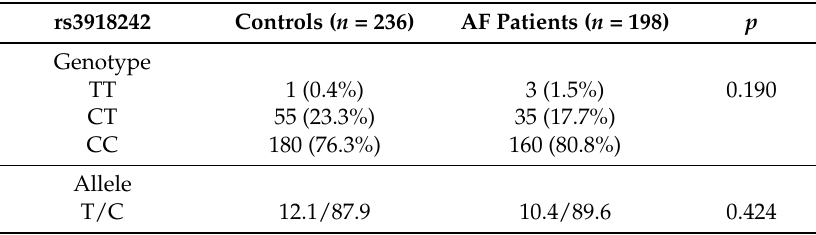
Table 2. Distribution of genotype and allele for MMP9 rs3918242 polymorphism in 200 patients with atrial fibrillation (AF) and 240